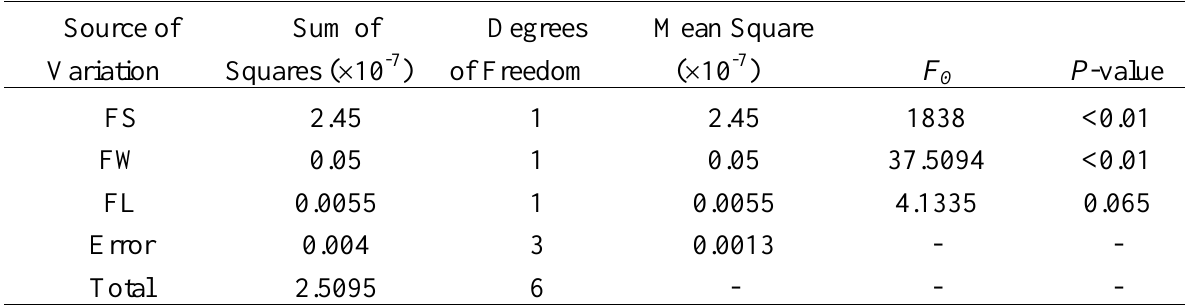
Table 4. ANOVA results for NDT-based sensing films.